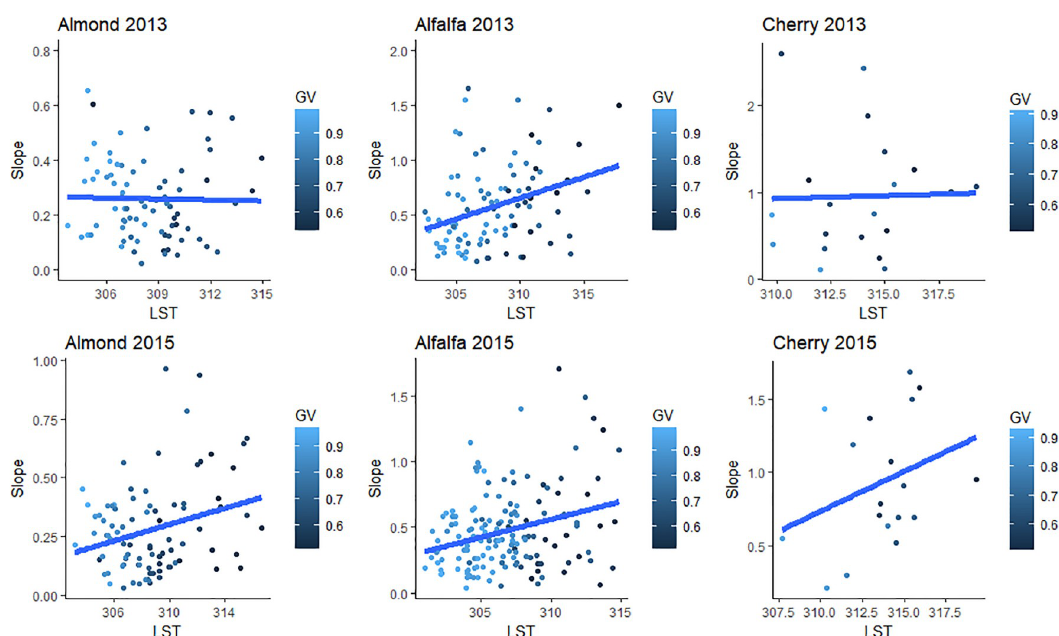
Fig 13. Field-level values of water vapor slope and field-level LST for alfalfa, almond, and cherry from 2013 and 2015. Points are colored by fractional GV coverage. Alfalfa 2013: Slope = -10.0+ 0.03 � LST, p = 0.013; Almond 2013: Slope = -6.6 + 0.02 � LST, p = 0.074; Cherry 2013: Slope = -1.1 + 0.007 � LST, p = 0.914; Alfalfa 2015: Slope = -7.9 + 0.03 � LST, p < 0.001; Almond 2015: Slope = -5.0 + 0.02 � LST, p = 0.008; Cherry 2015: Slope = -16.2 + 0.05 � LST, p =